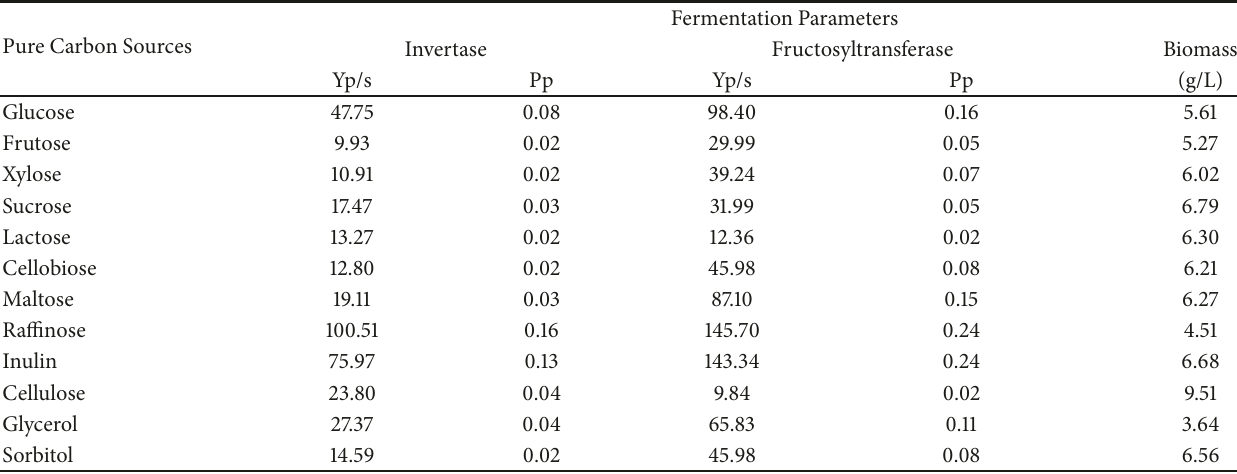
Table 2: Fermentation parameters for invertase and FTase production by A. carbonarius PC-4 on pure carbon